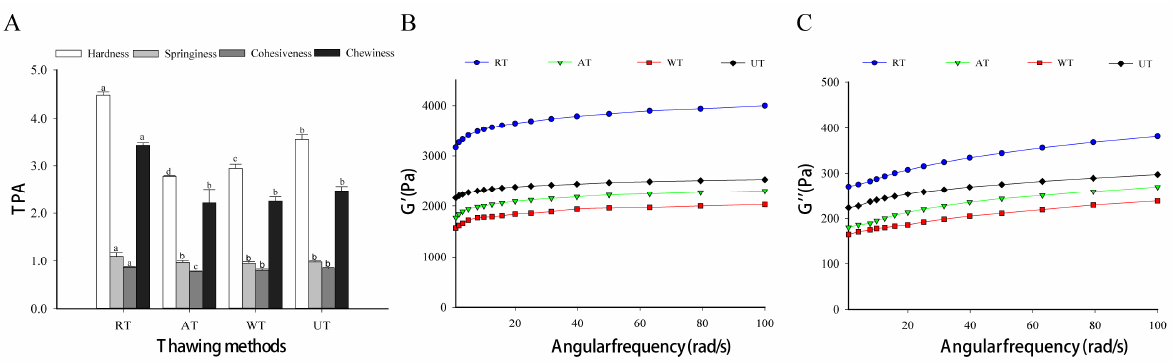
Figure 3. Influence of different thawing methods on TPA ( A ) and rheological properties ( B , C ) of frozen instant sea cucumber. ( B , C ) represent changes in the storage modulus and loss modulus. The units of hardness and chewiness are kilograms (kg). Values of different groups with different lowercase letters (a–d) are significantly different at p < 0.05.